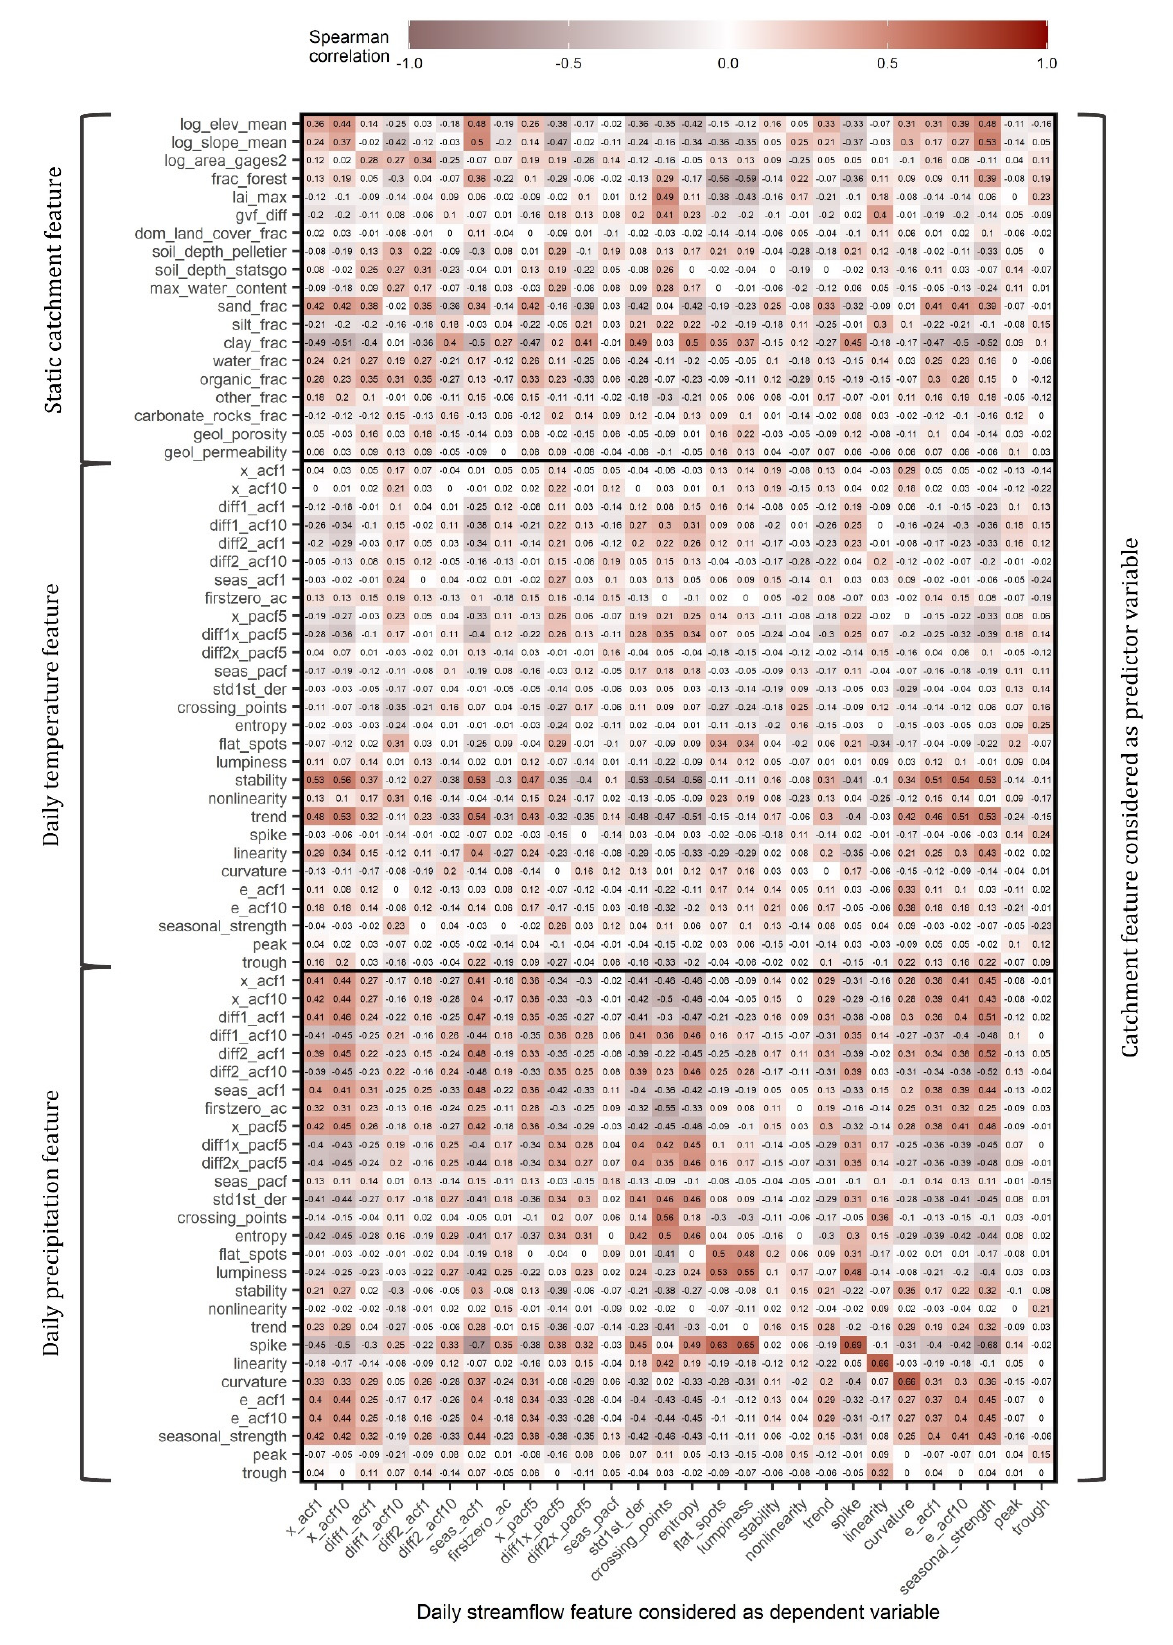
Figure 2. Spearman correlations between potential predictor and dependent variables of the investigated technical problem. The displayed feature abbreviations are explained in Sections 2.1 and 2.2.